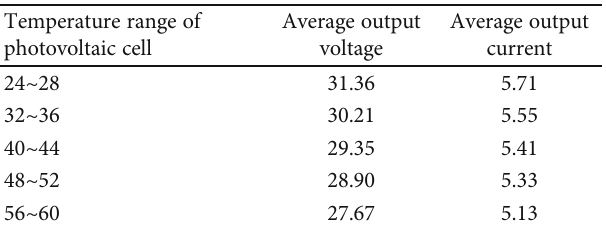
Table 5: Data under di ff erent light intensities. Light intensity